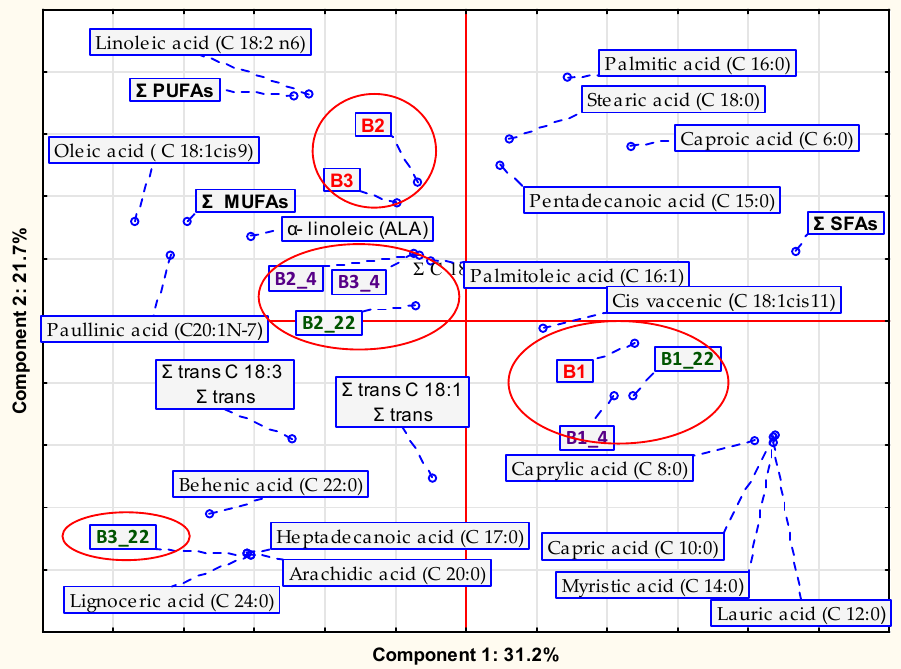
Figure 2. Principal Component Analysis graph of the proportion of particular fatty acids in organic protein bars depending on the storage conditions. B1; B2; B3—samples coded according to Section 2.1; Table 1; B1_4—sample B1 after 3 months storage at 4 °C, B1_22—sample B1 after 3 months storage at 22 °C, B2_4—sample B2 after 3 months storage at 4 °C, B2_22—sample B2 after 3 months storage at 22 °C, B3_4—sample B3 after 3 months storage at 4 °C, B3_22—sample B3 after 3 months storage at 22 °C.